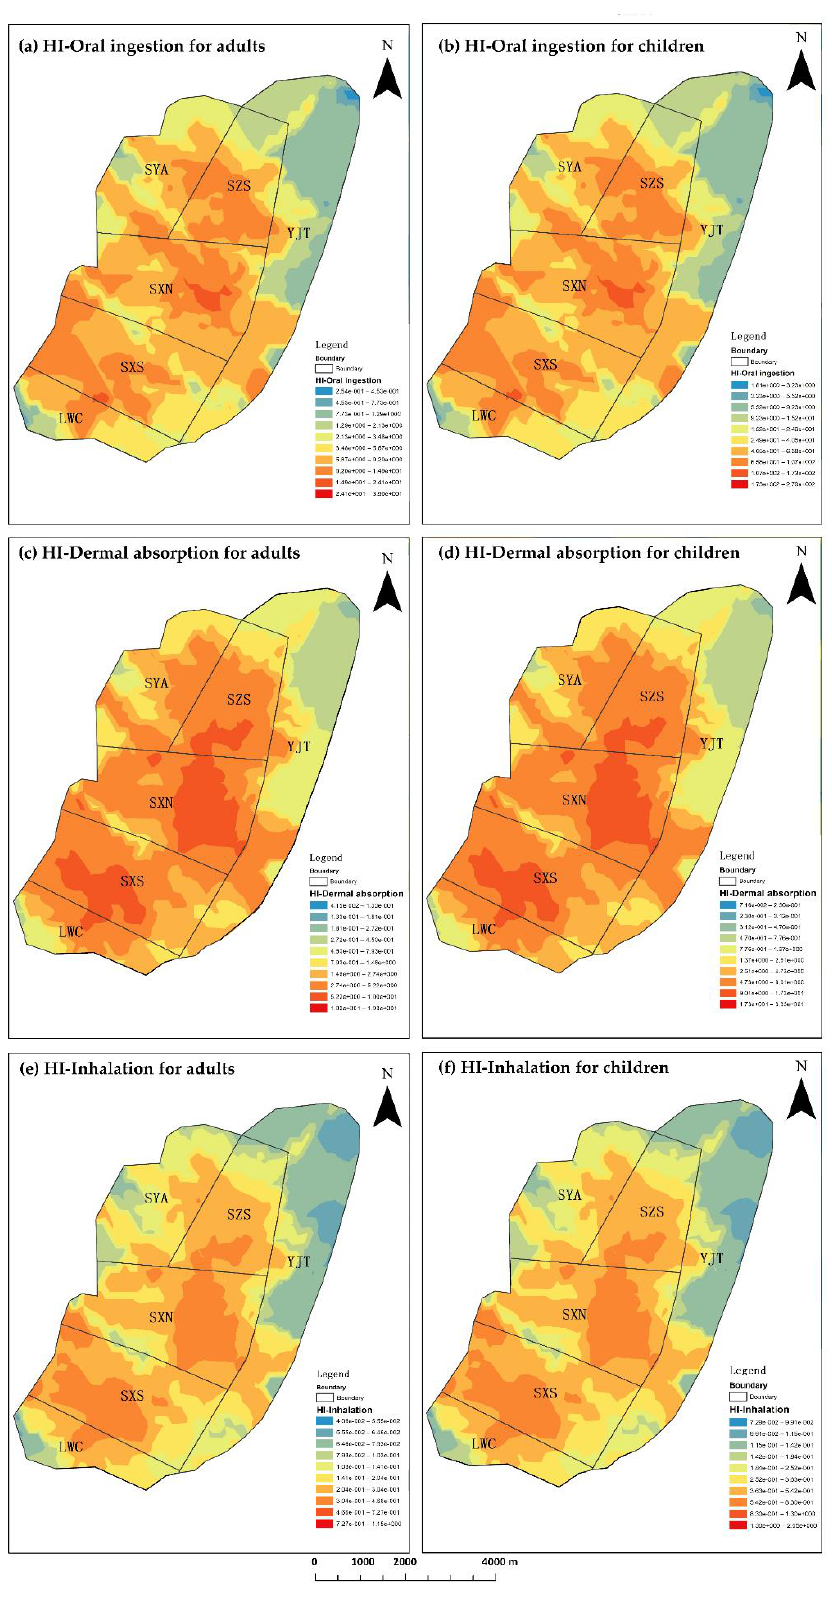
Figure 5. Spatial distribution of hazard index of PTEs from the six sampling sites.